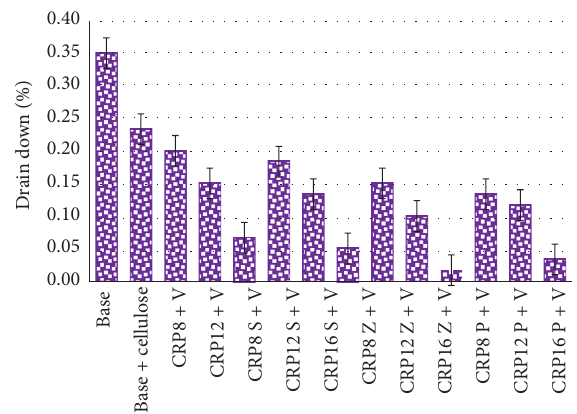
Figure 2: Drain down test results for different SMA mixtures.